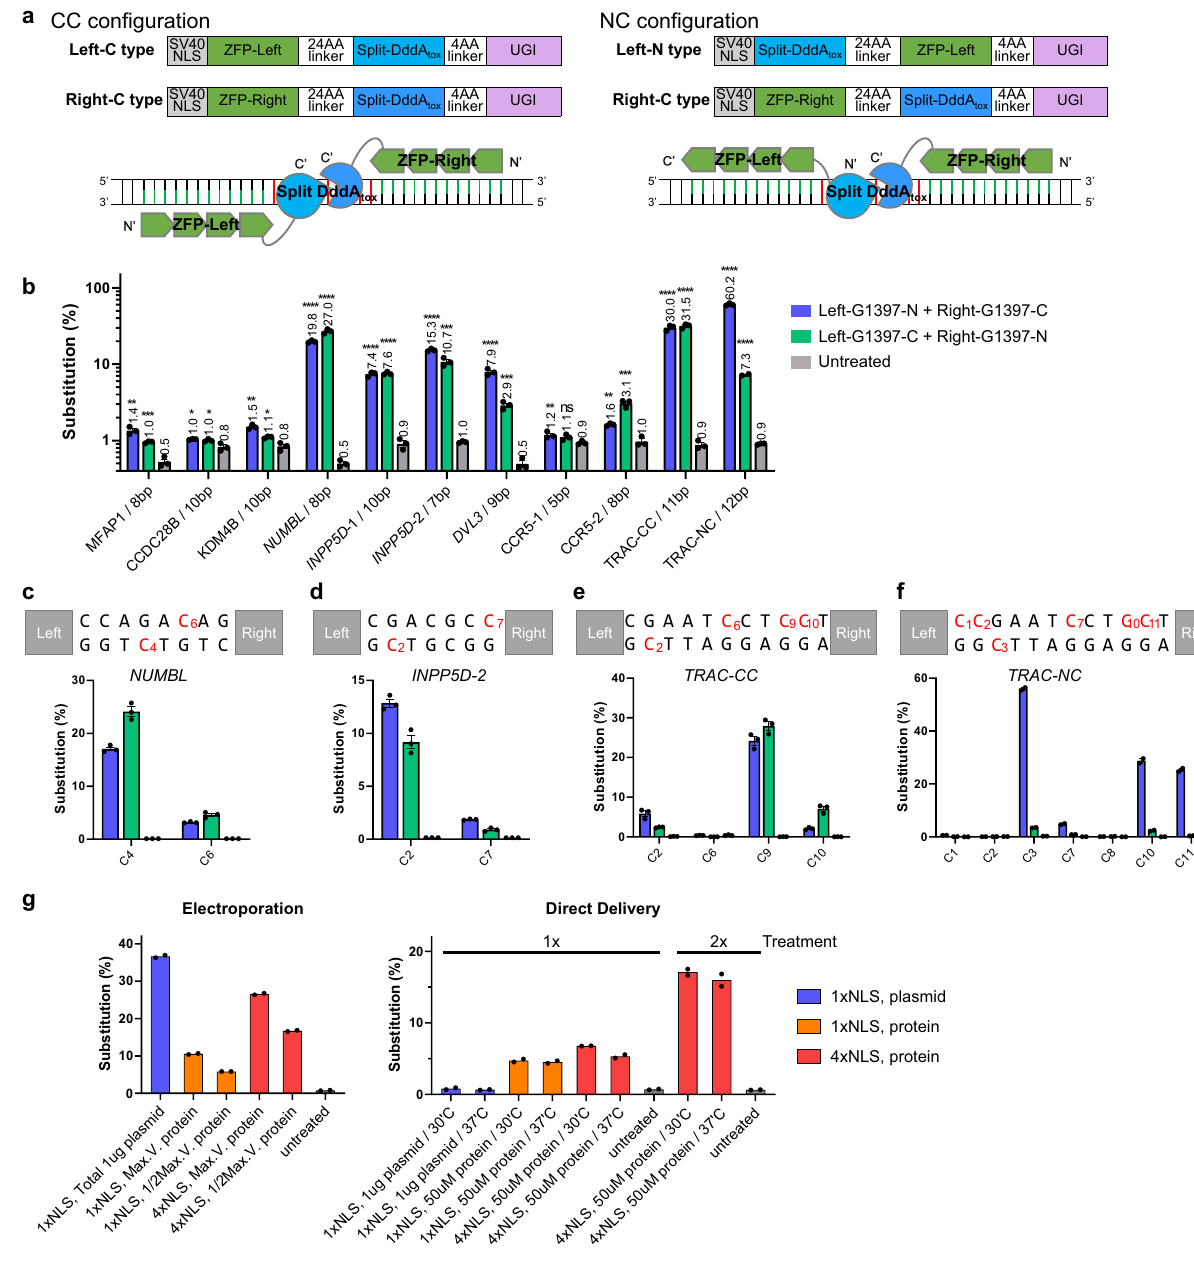
Fig. 2 Cytosine base editing by ZFDs at endogenous target sites. a Architecture of nuclear DNA-targeting ZFDs. Split-DddA tox halves are fused to the C terminus (C type) or N terminus (N-type) of ZFPs. ZFD pairs were designed in CC or NC con fi gurations, which are composed of a C-type left ZFD and a C-type right ZFD or an N-type left ZFD and a C-type right ZFD, respectively. b Base editing frequencies induced by ZFDs at endogenous target sites in HEK 293 T cells. All statistical analysis for comparing with untreated samples was conducted using unpaired Student ’ s t -test (two-tailed) in GraphPad Prism 8. Statistical signi fi cance as compared with untreated samples was denoted with * P ≤ 0.05, ** P ≤ 0.01, *** P ≤ 0.001, **** P ≤ 0.0001, n.s. (not signi fi cant) P > 0.05. Data are shown as means with standard error of the mean (s.e.m.) from n = 3 biologically independent samples. c – f ZFD-induced base editing ef fi ciencies at each base position within the spacer at the NUMBL ( c ), INPP5D-2 ( d ), TRAC- CC ( e ), and TRAC- NC ( f ) target sites in HEK 293 T cells. Data are shown as means ± s.e.m. from n = 3 biologically independent samples. g ZFD-induced base editing frequencies in K562 cells following electroporation or direct delivery of ZFDs or ZFD-encoding plasmids. ZFD proteins with one or four NLSs were tested, and equimolar amounts of left and right ZFDs were used. Electroporation was performed using an Amaxa 4D-Nucleofector. For direct ZFD delivery, K562 cells were incubated with a cell medium containing left and right ZFD proteins. Cells were treated either once (1x) or twice (2x) in the same way. Data are shown as means from n = 2 biologically independent samples. Source data are provided as a Source Data fi